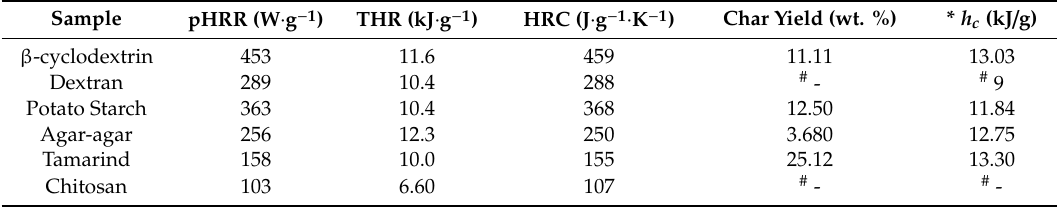
Table 5. Relevant parameters from PCFC tests.